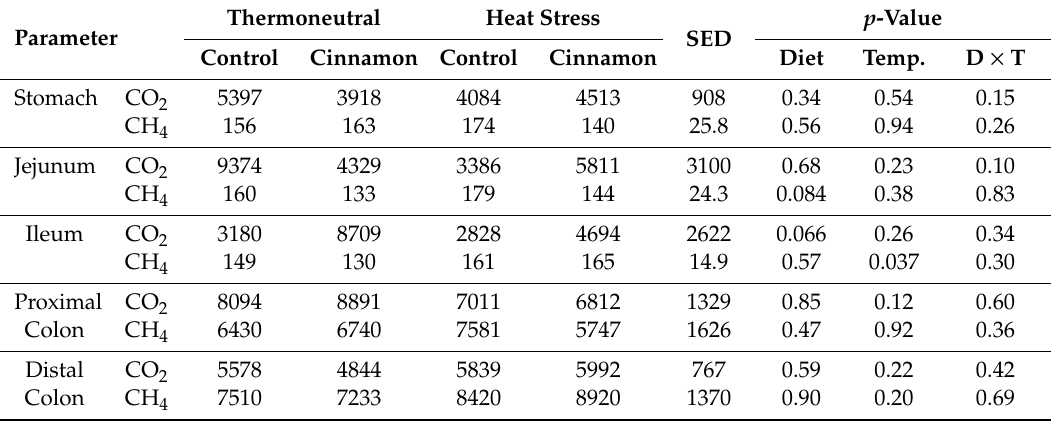
Table 5. E ff ect of dietary cinnamon (control vs. 1.5%) and thermoneutral vs. heat stress conditions on CO 2 and CH 4 concentrations in gas from the gastrointestinal